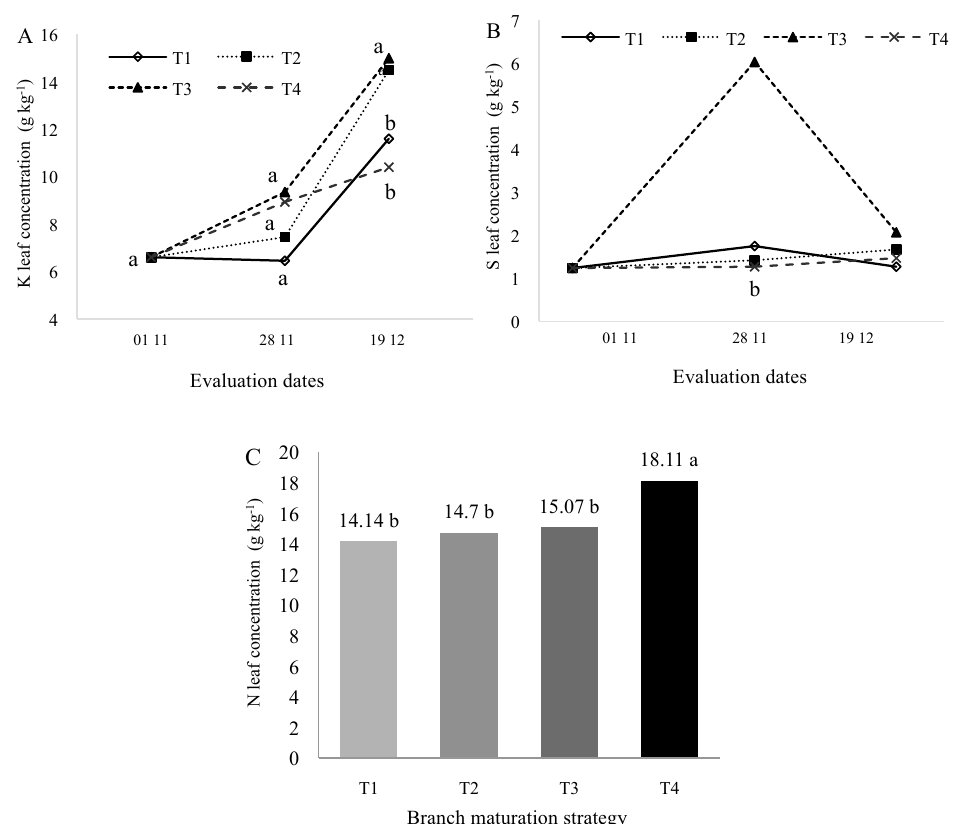
Fig. 3: Leaf concentrations of potassium (A), sulphur (B) at the beginning, middle and end of shoot maturation; and nitrogen (C) at the end of shoot matura- tion of mango cv. Palmer as a function of shoot maturation strategy. Points or bars with the same letters do not differ in among themselves by Tukey’s test at 1% probability in each evaluation date. T1) biostimulant foliar spray + K fertilizer; T2) foliar spray with biostimulant alternating with K fertilizer; T3) individual foliar sprays (magnesium sulfate, potassium sulfate, sulfur and calcium fertilizers, potassium fertilizer, and Ethrel ® ; and T4) Control